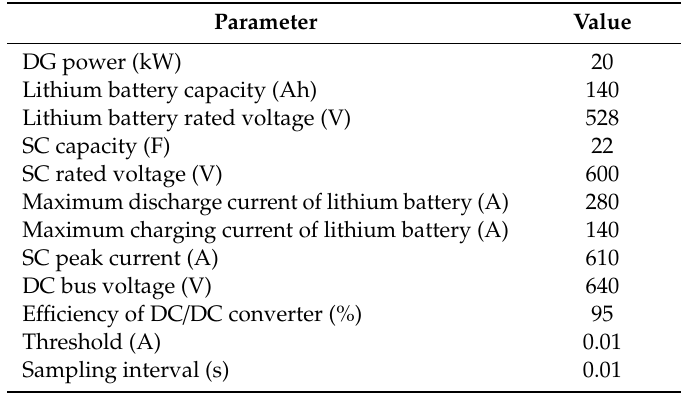
Table 1. Parameters of the hybrid system in simulation. DG—diesel generator; SC—supercapacitor; DC—direct current.